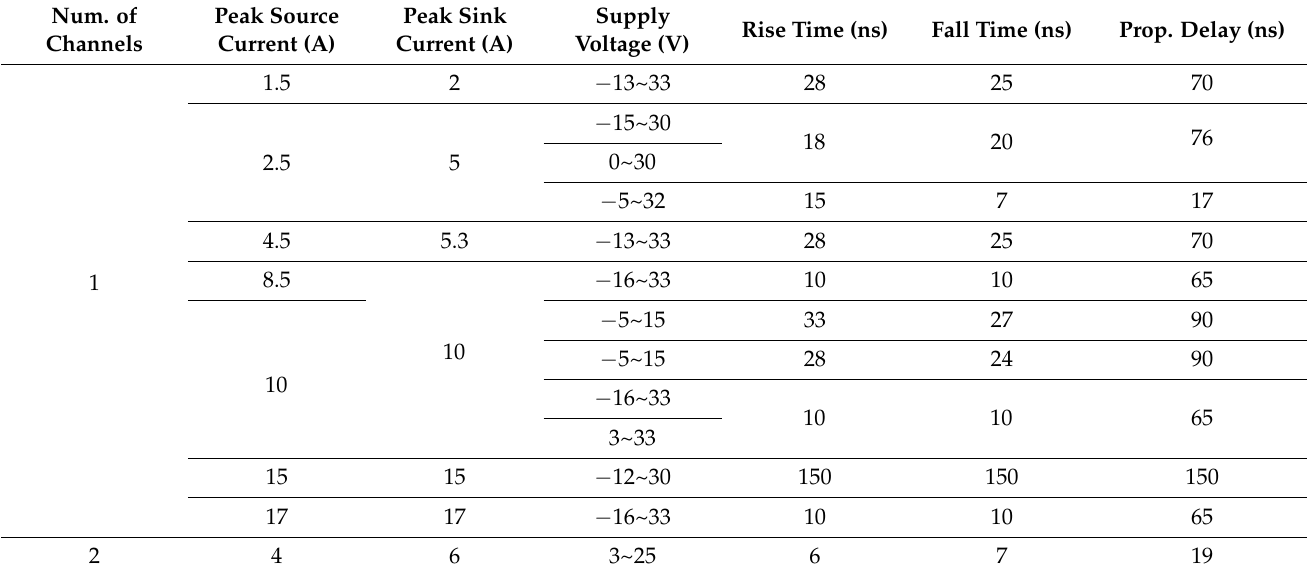
Table 34. Commercial SiC MOSFET drivers by Texas Instruments.